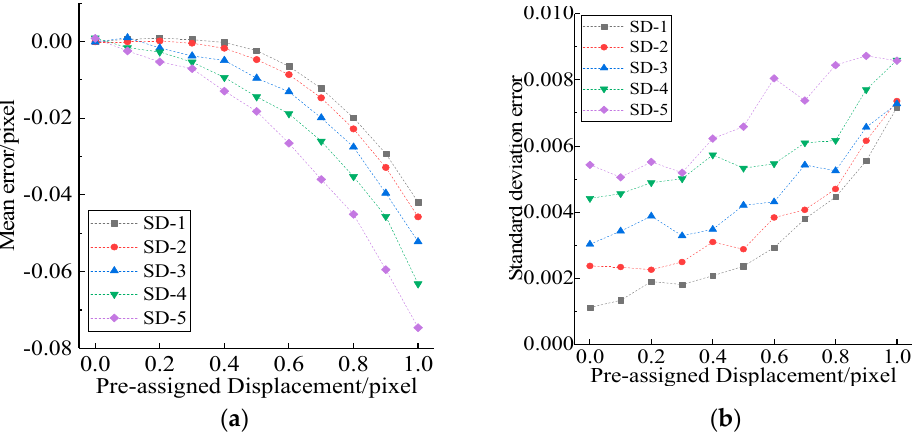
Figure 5. Matching error with noise and the interpolation centered at 0 pixel: ( a ) mean error; ( b ) standard deviation error.